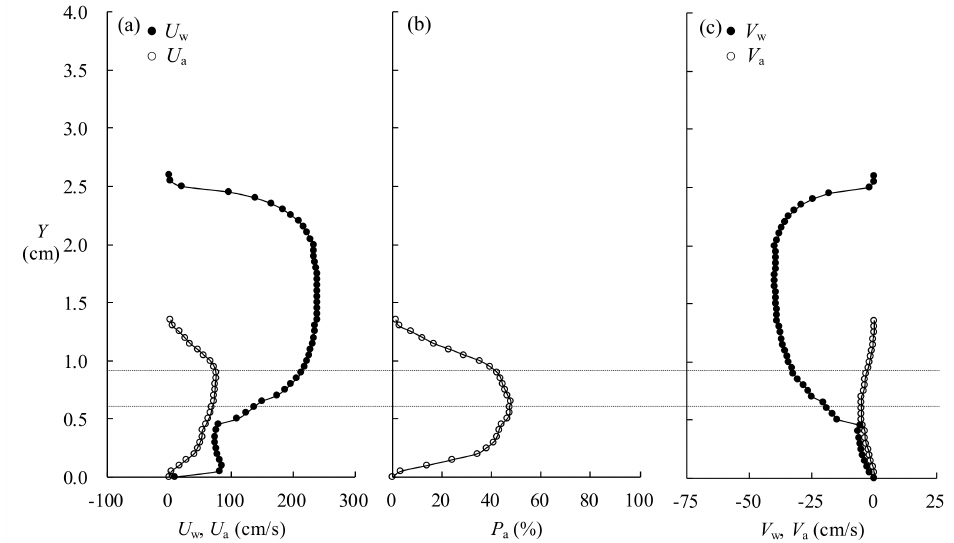
Figure 26. Relationship among ( a ) the profiles of mean streamwise velocities of both water stream and air-bubble phases, ( b ) the probability distribution for intermittent occurrence of air bubbles, and ( c ) the profiles of mean transverse velocities of both phases at X = 17.0